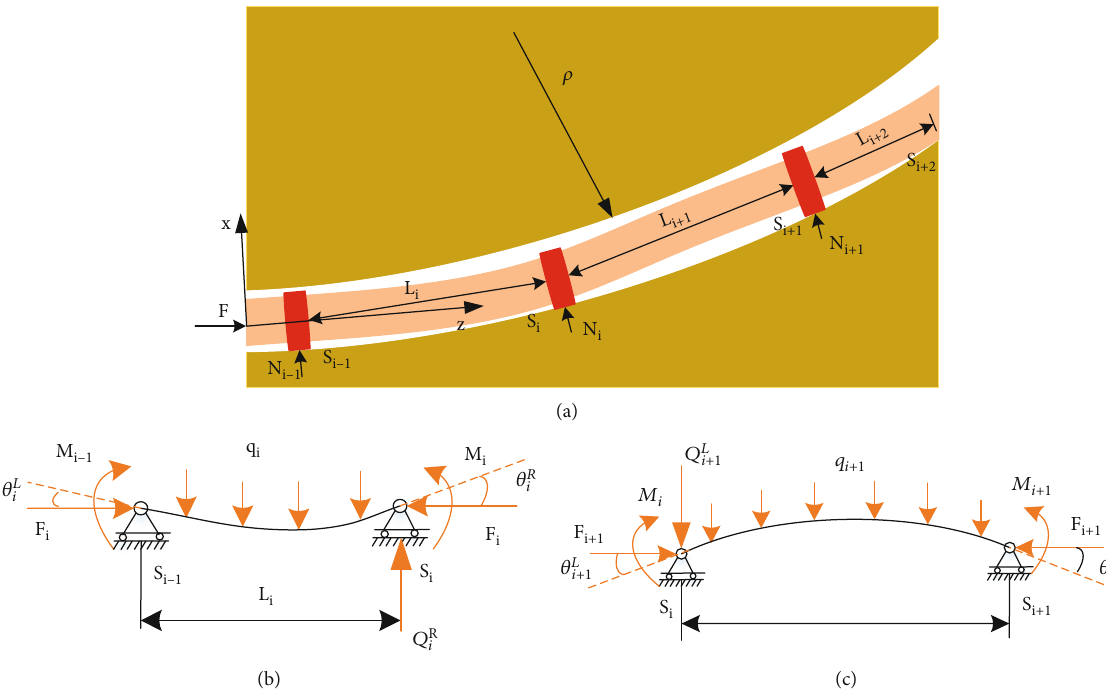
Figure 2: Force and deformation of casing string running in a curved section. (a) Schematic diagram of casing string running in a curved section. (b) Force and deformation of the i th span beam. (c) Force and deformation of the ð i + 1 Þ th span beam.